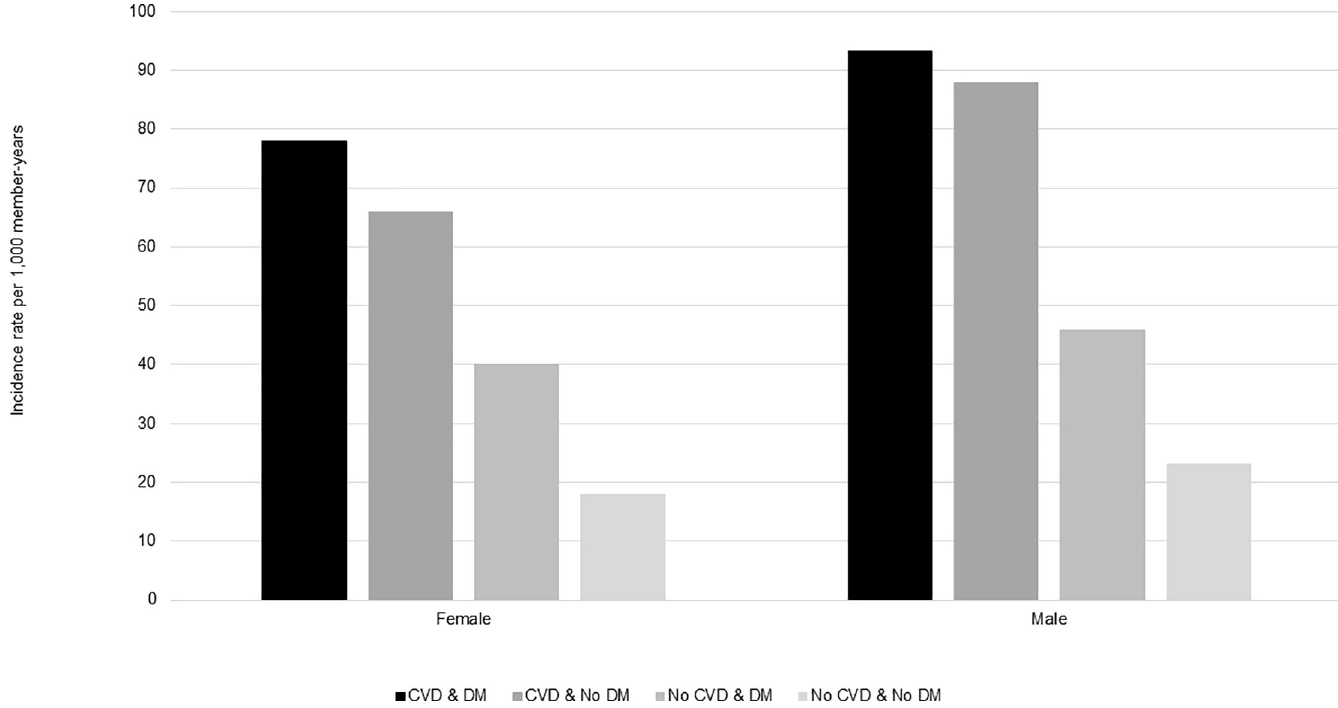
Fig 5. Statin initiation rates among older adults aged > 75 years with and without cardiovascular disease and diabetes mellitus by sex, and who go on to use statins long-term, � NIH Collaboratory Distributed Research Network, January 1, 2008- March 31, 2018. Abbreviations: CVD = cardiovascular disease; DM = diabetes mellitus � Long-term use was defined as a minimum of 180 days of statin exposure based on the number of days supplied, allowing for gaps of up to 30 days and including an exposure episode extension period of 30 days.